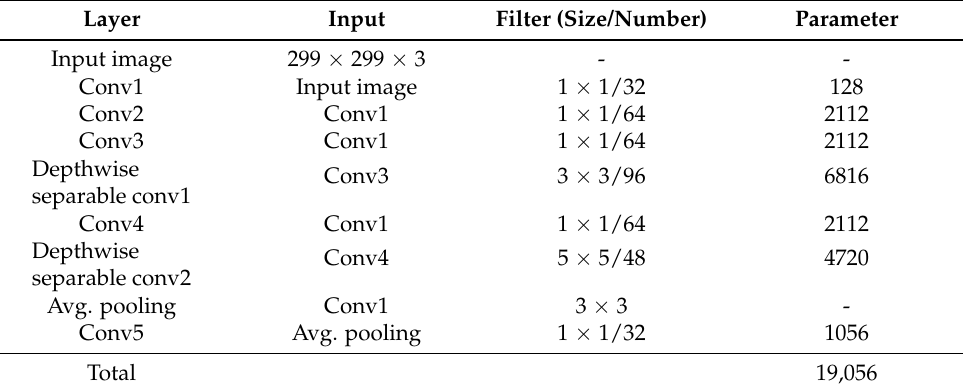
Table 4. Required parameters using depthwise separable convolution in the Inception block.